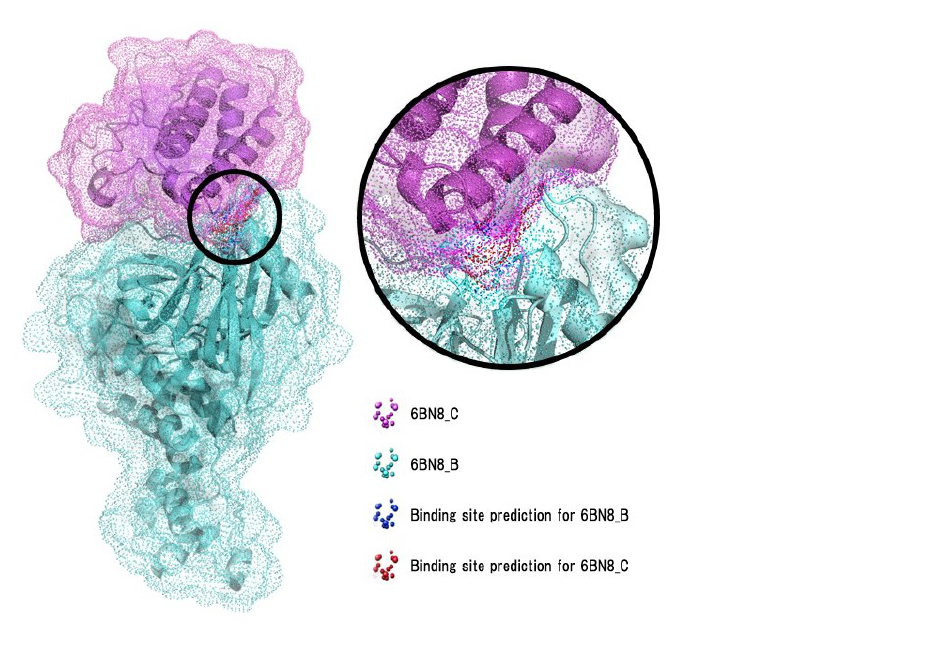
Figure 5. Biochemical representation of predictions for the CRBN–BRD4 complex without the dBET55 degrader (PDB ID: 6BN8). Surface point clouds are superimposed to the original PDB structure. Blue and red points indicate interacting points prediction for chains B and C, respectively (AUROC: 0.987, inference performed using the model trained on the “super”